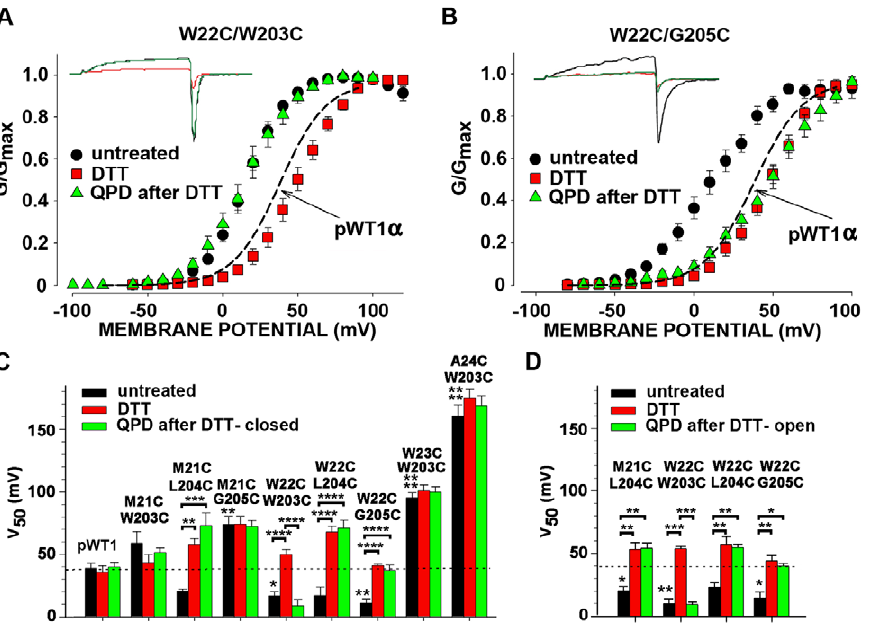
Figure 2. Effects on V 50 of endogenously formed S0-S4 disulfide bonds, their reduction, and their QPD-induced reformation at the cell surface. (A, B) Macroscopic currents (insets) and normalized G-V curves of untreated cells expressing W22C/W203C (A) or W22C/G205C (B), after treatment with 10 mM DTT (pH 7.5) for 5 min, and after subsequent treatment with 40 m M QPD (pH 7.5) for 2 min. Recordings were from outside-out macropatches with 10 m M Ca 2 + inside the pipette. At each potential, the mean relative conductance averaged from several cells is plotted. The mean G-V curve for pWT1 a is shown as a dashed-line. (C) Mean V 50 6 SD of the V 50 s from the individual fits of the Boltzmann equation to the currents from each cell. The V 50 s were determined after endogenous disulfide crosslinking (black bars), after subsequent DTT (red bars), and finally after 40 m M QPD (green bars). The mean V 50 for pWT1 a is shown as a dashed-line. In C, the macropatches were held at 2 100 mV (closed state) during the QPD- induced reoxidation. N=3–11. (D) As C, except that the patches were held at + 80 mV (open state) during the application of QPD. The mean V 50 for pWT1 a is shown as a dashed-line. * P , 0.05, **P , 0.01, *** P , 0.001, **** P , 0.0001 by one-way Anova followed by Tukey’s post-hoc analysis for multiple comparisons between brackets. Without brackets, comparison to pWT1 a by one-way Anova followed by Tukey’s post-hoc analysis.